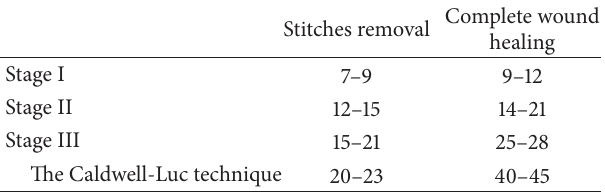
Table 6: Soft tissues healing time